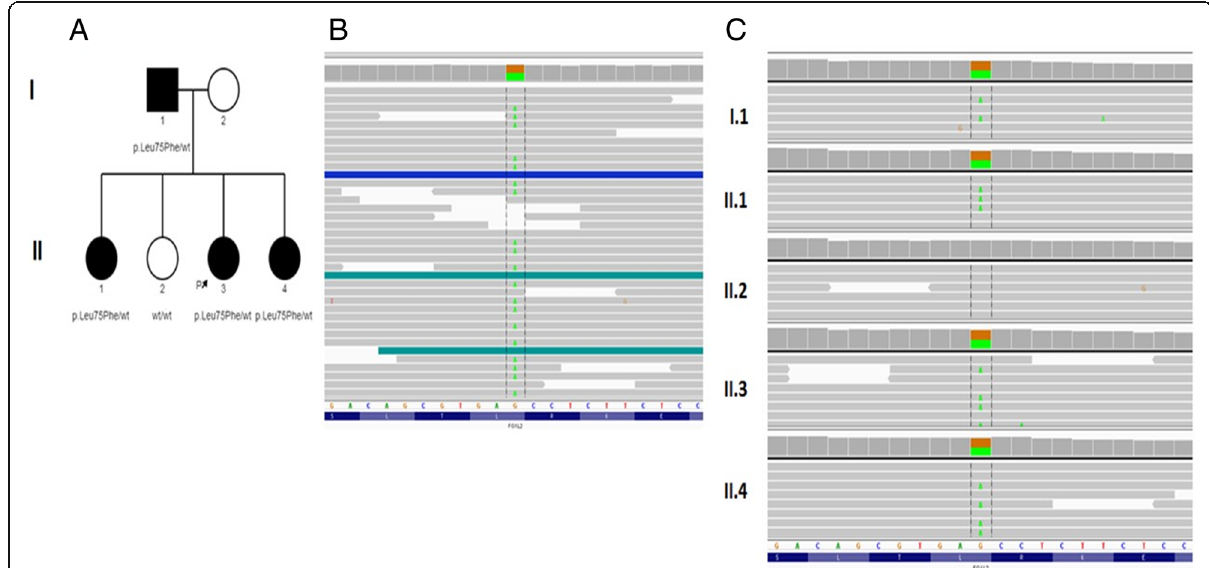
Fig. 3 Sequencing results: a Pedigree of studied family, proband is marked with black arrow. b Next-generation Sequencing results of c.223C > T p.(Leu75Phe) variant in the FOXL2 gene in the proband using Integrative Genomic Viewer (IGV). c Amplicon deep sequencing (ADS) results in the FOXL2 gene in the studied family (IGV